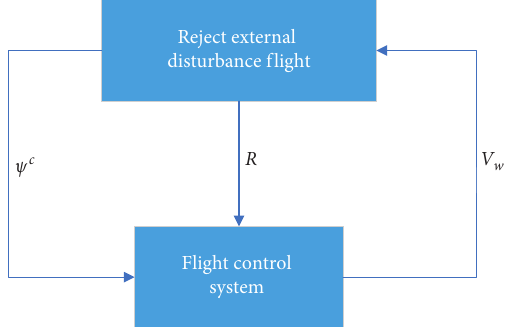
Figure 4: Signal transmission diagram of the “reject external disturbance” flight mode controller and UAV system.